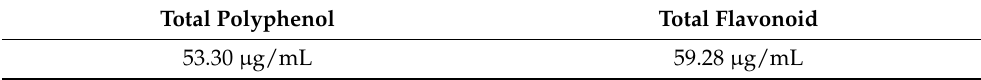
Table 3. Total polyphenol and flavonoid contents of GF